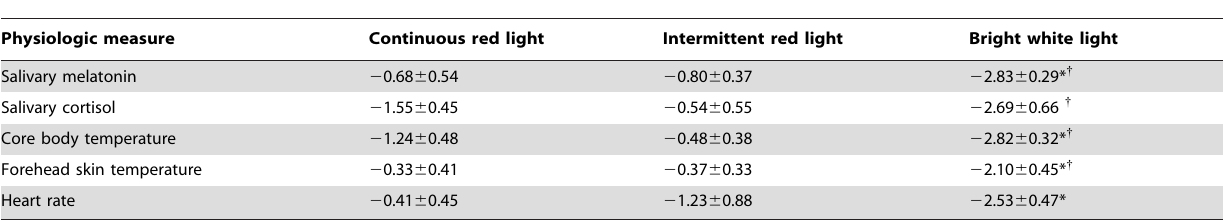
Table 1. Circadian phase shift responses to light (h 6 SEM).